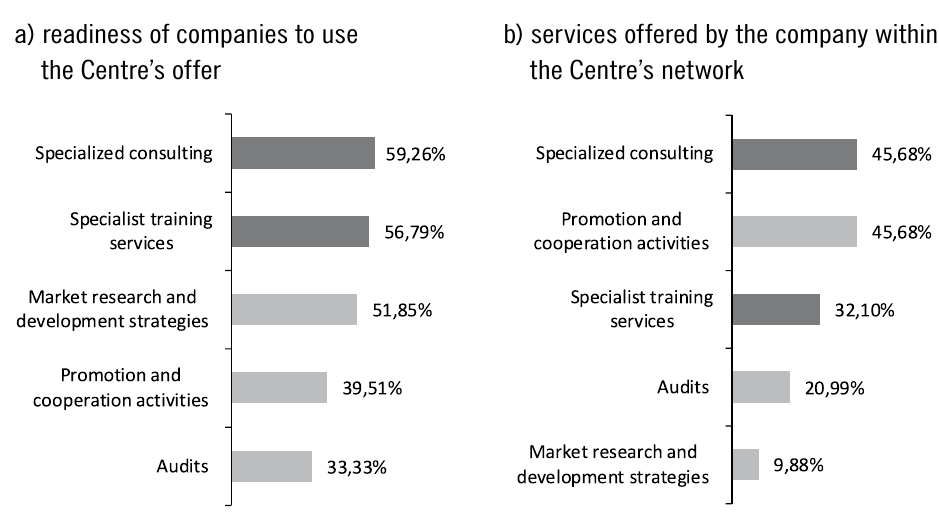
Figure 5. Competence need awareness among companies and the possibility of satisfying such needs – CAWI